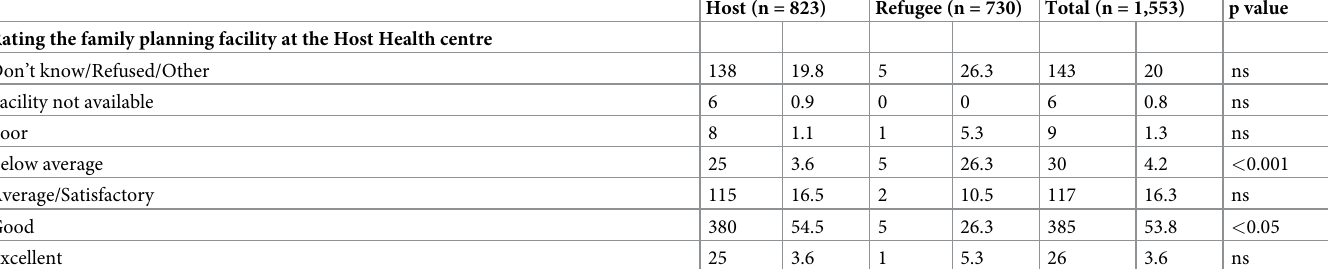
(Table 4). In particular, key informants agreed on the benefits of FP service providers engaging in two-way dialogues with communities to facilitate open question and answer sessions about FP (KI113,